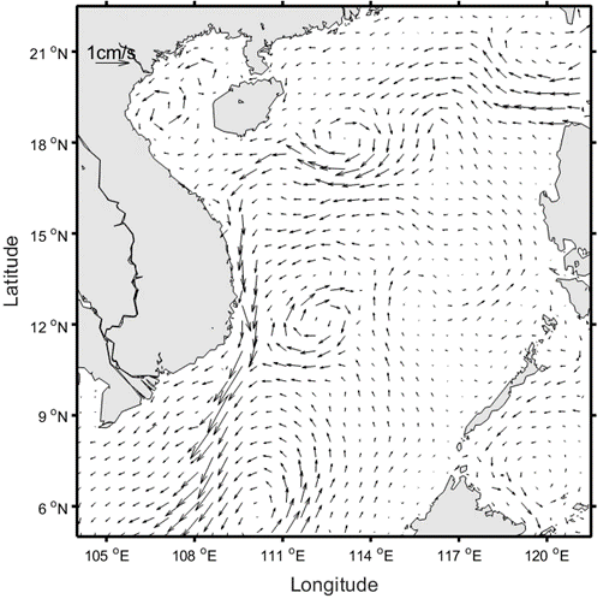
Figure 1. Monthly mean surface flow field in December (unit: cm/s).